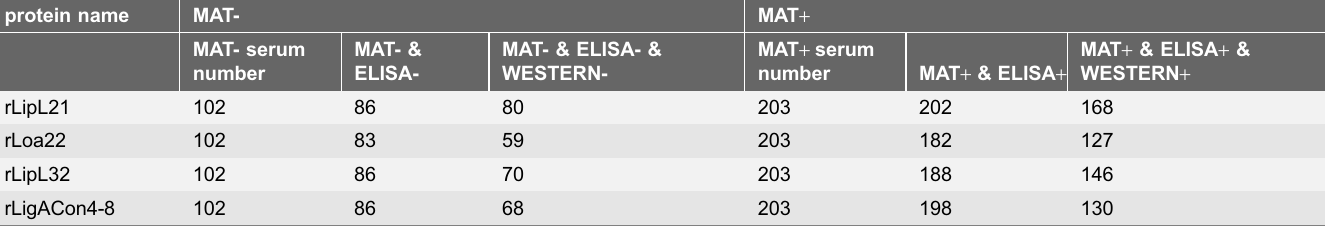
Table 1. MAT, ELISA and Western blot analysis of the serum sample used in this study. protein name